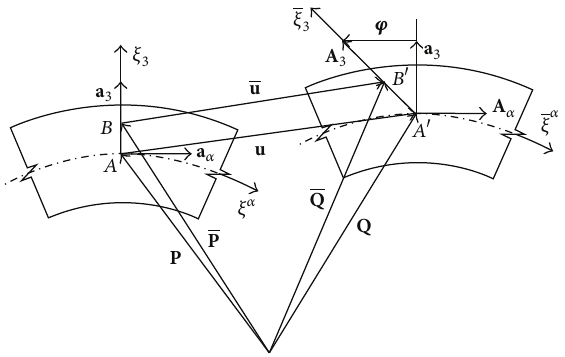
Figure 1: Kinematics of the first-order shear deformation